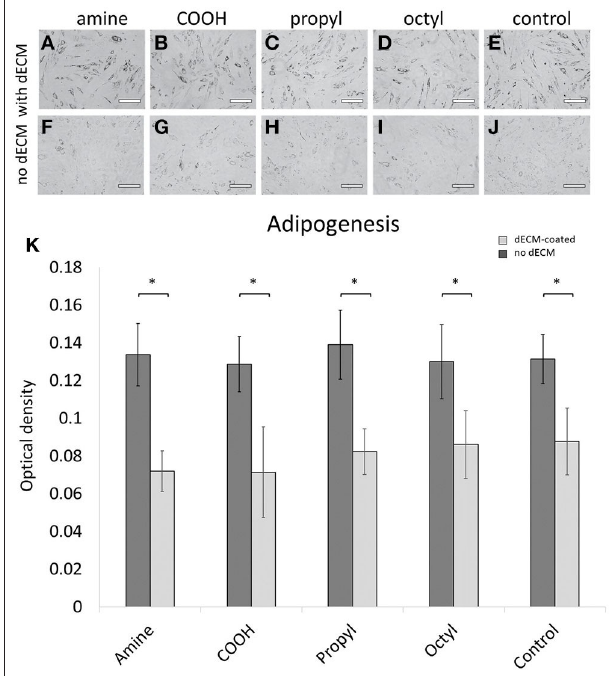
FIGURE 4 | Primary MSCs were differentiated down adipogenic lineages and stained for adipogenesis using Oil Red O on (A–E) dECM-coated surfaces and (F–J) surface-modified glass controls. (K) Adipogenesis was quantified through solubilization and intensity measurements of Oil Red O stain. Scale bars represent 200 µ m. Brackets indicate significant differences, with * < 0.05. All means were statistically compared using a two-way ANOVA and a Tukey’s post-hoc test. However, only differences between a dECM-coated surface and its surface chemistry control are indicated for